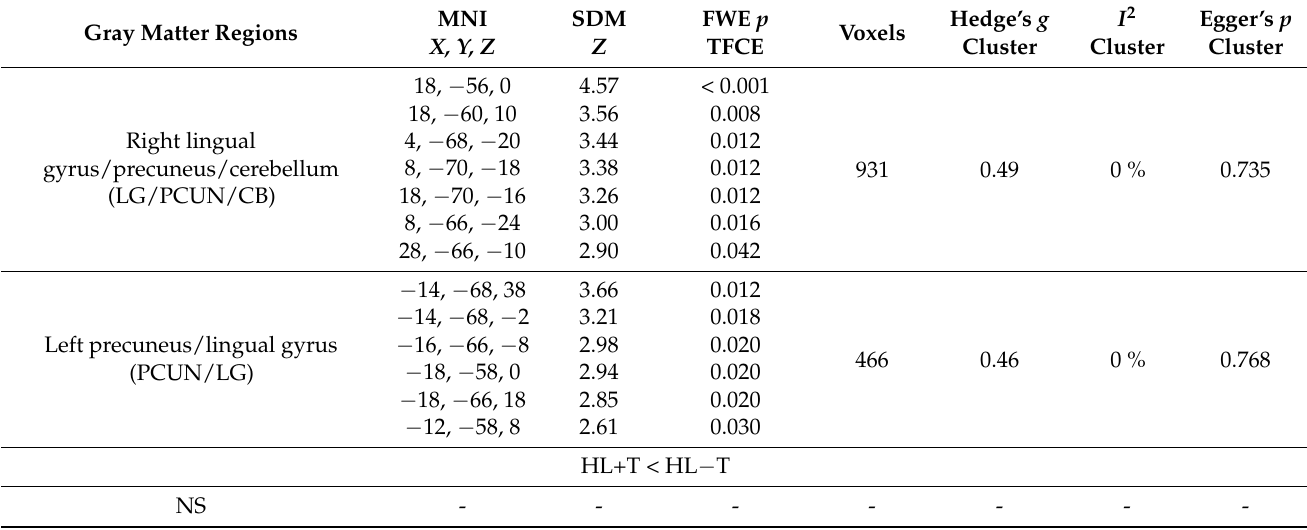
Table 3. Whole-brain meta-analyses of studies comparing individuals with and without tinnitus.